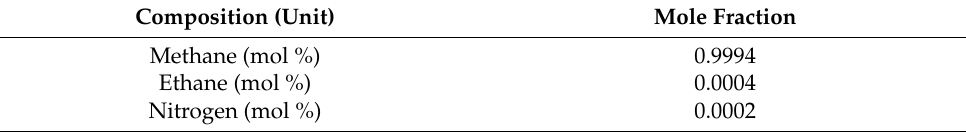
Table 2. Chemical compositions of the BOG. Composition